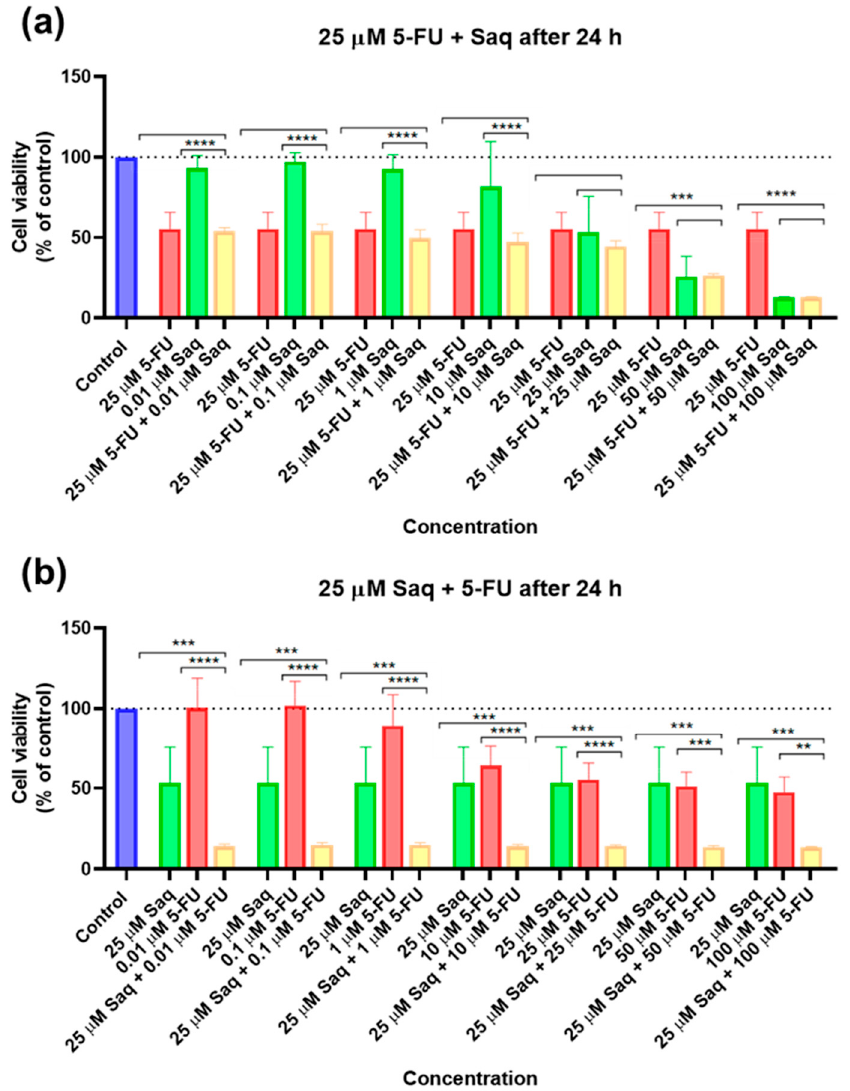
Figure 9. Cytotoxic results of PC-3 after exposure to drug combinations with the second drug only being added 24 h after the first. ( a ) Combination of 25 µ M of 5-FU with increasing concentrations of saquinavir (0.01–100 µ M); ( b ) combination of 25 µ M of saquinavir with increasing concentrations of 5-FU (0.01–100 µ M). Control cells were treated with 0.01% DMSO (vehicle). Cell viability was obtained using the MTT assay after 48 h, and the results are given as the mean ± SEM ( n = 3). ** statistically significant vs. drug alone at p < 0.01; *** statistically significant vs. drug alone at p < 0.001; **** statistically significant vs. drug alone at p < 0.0001.